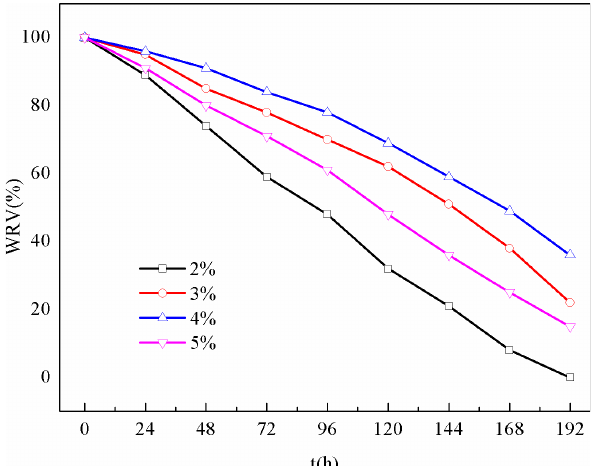
Figure 4: Water retention properties of foam gel at different SDS concentrations